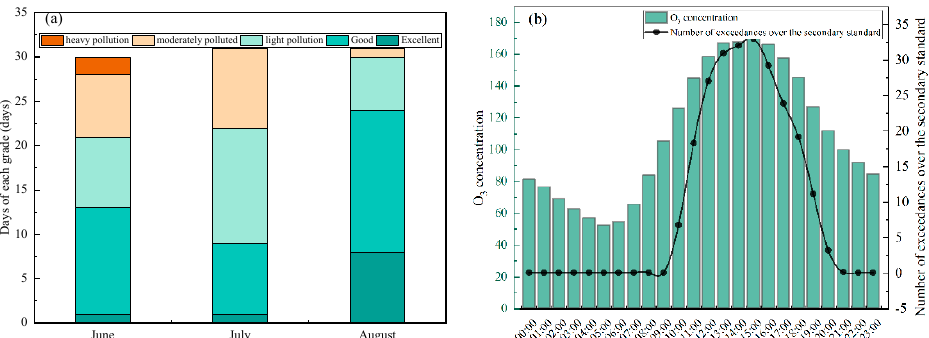
Figure 2. ( a ) Air quality classification during monitoring ( b ) Hourly-mean O 3 concentration of Tianjin (average of the hourly concentration from all monitors at each hour) and the number of exceedances over the secondary standard (160 µ g/m 3 ) for each hour during monitoring.